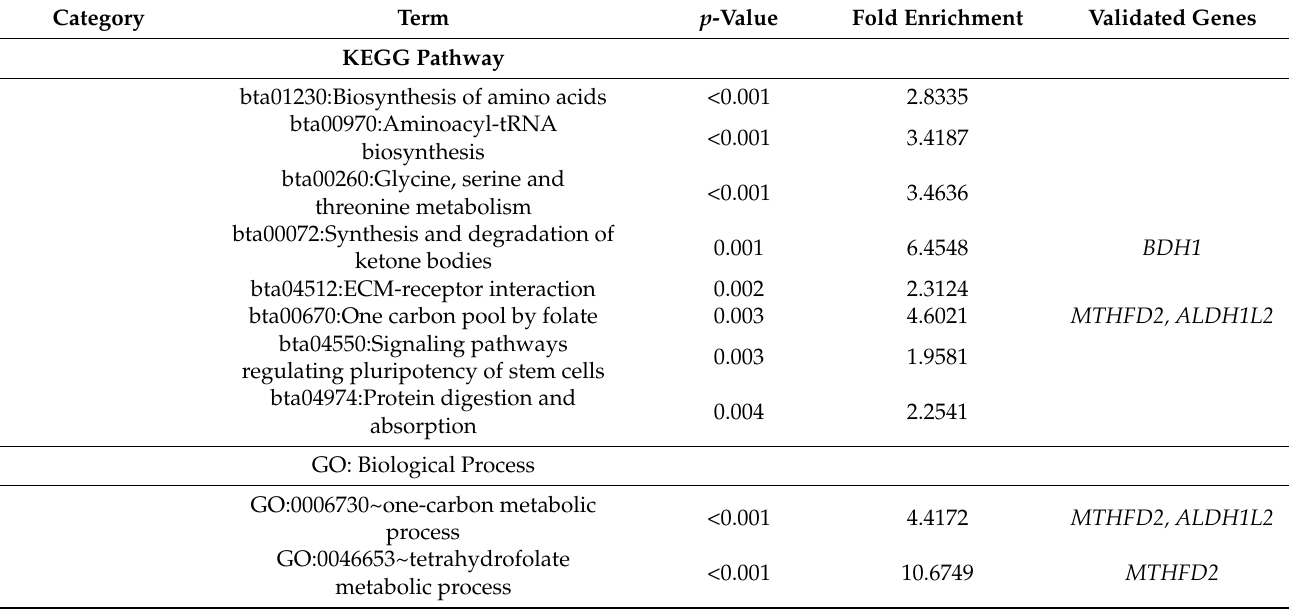
* Top 20 metabolisms/pathways extracted at p < 0.05 are listed. BDH1: 3-hydroxybutyrate dehydrogenase 1, MTHFD2: methylenetetrahy- drofolate dehydrogenase (NADP+ dependent) 2, methenyltetrahydrofolate cyclohydrolase, ALDH1L2: aldehyde dehydrogenase 1 family member L2.